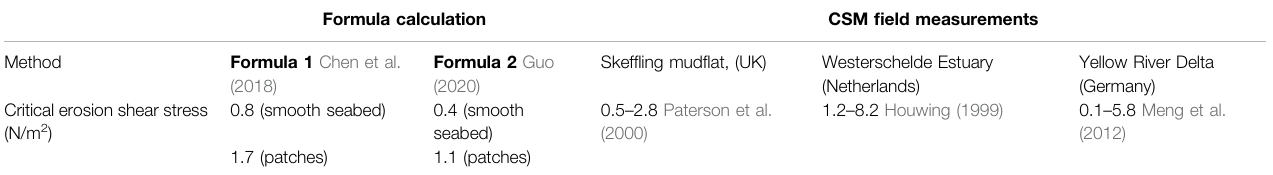
TABLE 2 | Substrate erosion thresholds calculated using two different equations based on physical properties of the sediment, compared to that measured with CSM on other tidal fl ats around the world. Formula